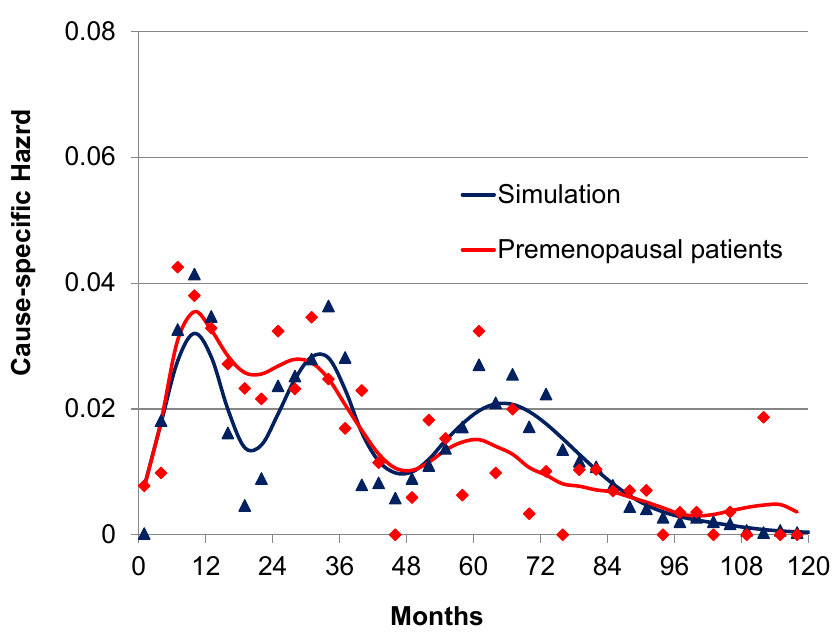
Figure 6. Simulation of Milan data in blue and actual Milan data for premenopausal patients in red. Format is disease free